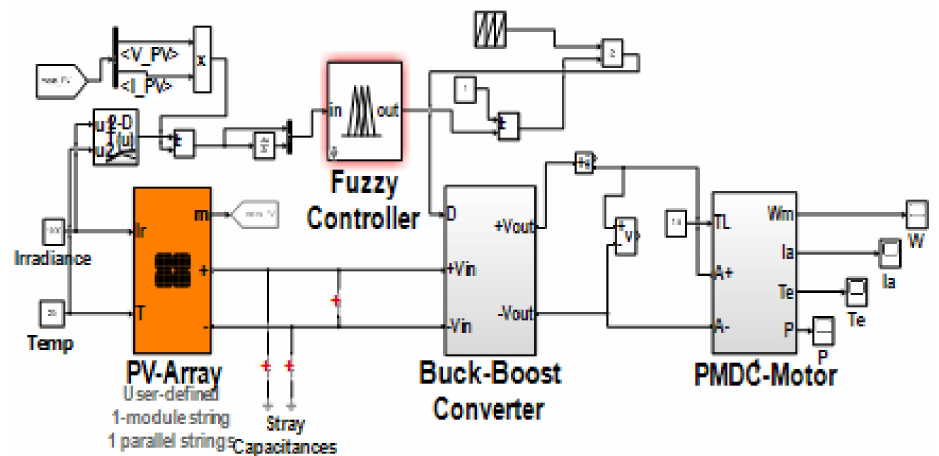
Figure 10. Simulink model of the system with the normal FLC.